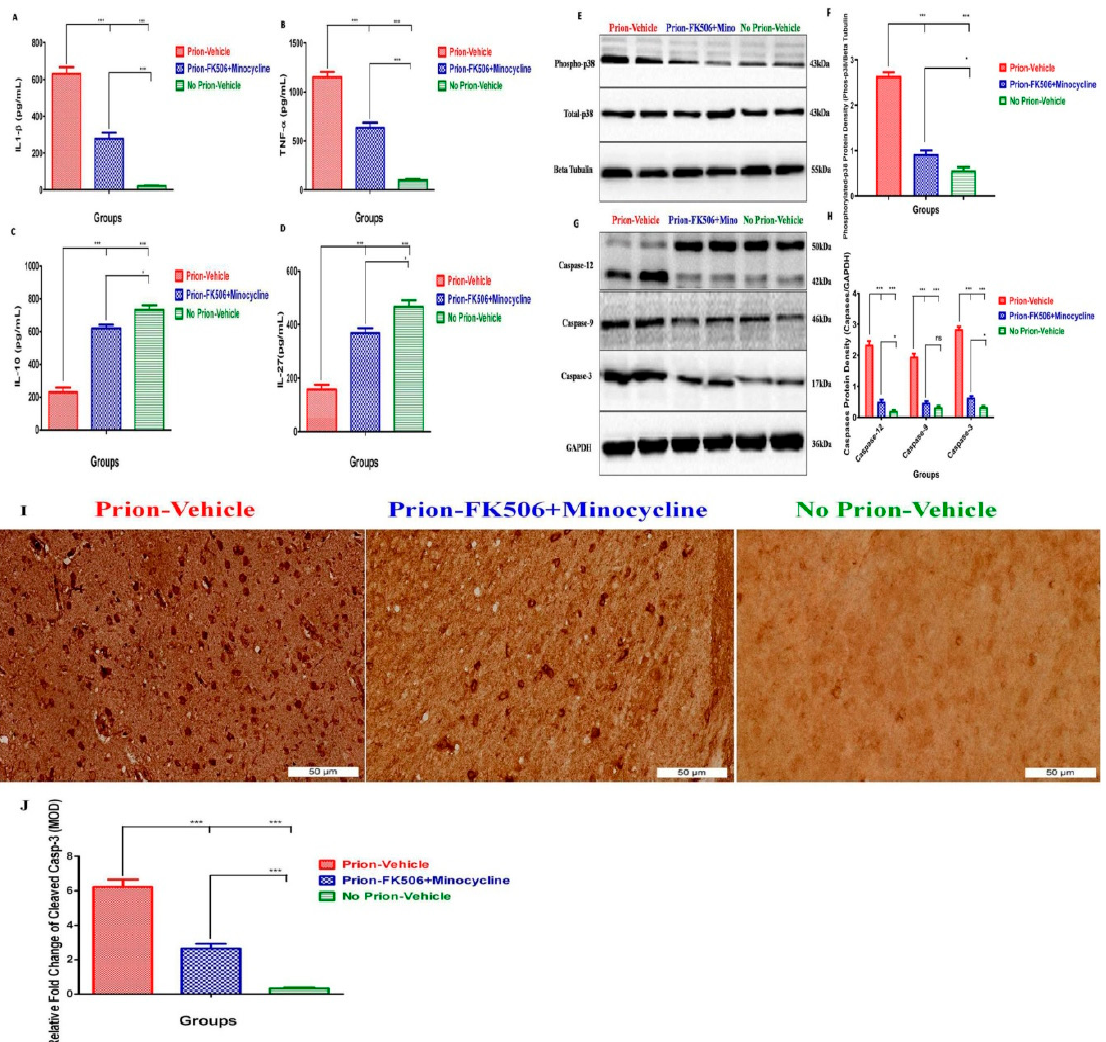
Figure 6. FK506+minocycline modulates caspase-dependent MAPK pathway in prion infected hamsters. ( A ) Showing the level of interleukin 1 beta (IL 1- β ) in brain homogenates of 5 animals per group using ELISA technique. The data was analyzed by using one way ANOVA test followed by post hoc test tukey’s multiple comparison. ( P < 0.0001 = ***). ( B ) Showing the level of tumor necrosis factor alpha (TNF- α ) in the brain homogenates of 5 animals per group using ELISA technique. The data was analyzed using one way ANOVA test followed by post hoc test tukey’s multiple comparison. ( P < 0.0001 = ***). ( C ) Showing the level of tumor necrosis interleukin-10 (IL-10) in the brain homogenates of 5 animals per group using ELISA technique. The data was analyzed using one way ANOVA test followed by post hoc test tukey’s multiple comparison. ( P ≤ 0.05 = * and P < 0.0001 = ***). ( D ) Showing the level of interleukin-27 (IL-27) in the brain homogenates of 5 animals per group using ELISA technique. The data was analyzed using one way ANOVA test followed by post hoc test tukey’s multiple comparison. ( P ≤ 0.05 = * and P < 0.0001 = ***). ( E ) Representative western blots of two animals each from every group for protein expression of MAPK phosphorylated p38 level and total MAPK p38 level. ( F ) Data showing the graphical presentation of the expression level of MAPK phosphorylated p38 and total MAPK p38 level in brain homogenates of 5 animals each per group. Values were normalized using beta tubulin as loading control. The data was analyzed using one way ANOVA test followed by post hoc test tukey’s multiple comparison. ( P ≤ 0.05 = * and P < 0.0001 = ***). ( G ) Representative western blots of two animals each per group for caspase-12,